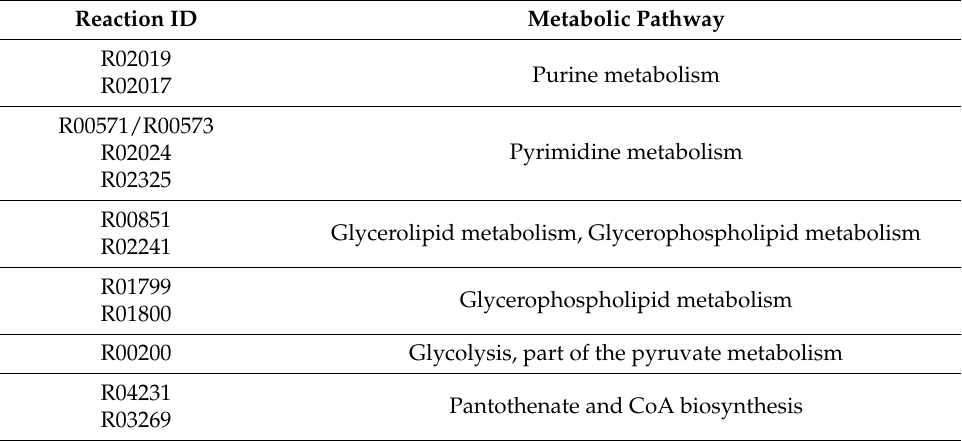
Table 2. Essential reactions of the m-DAG constructed from the theoretical minimal gene set machin- ery needed for